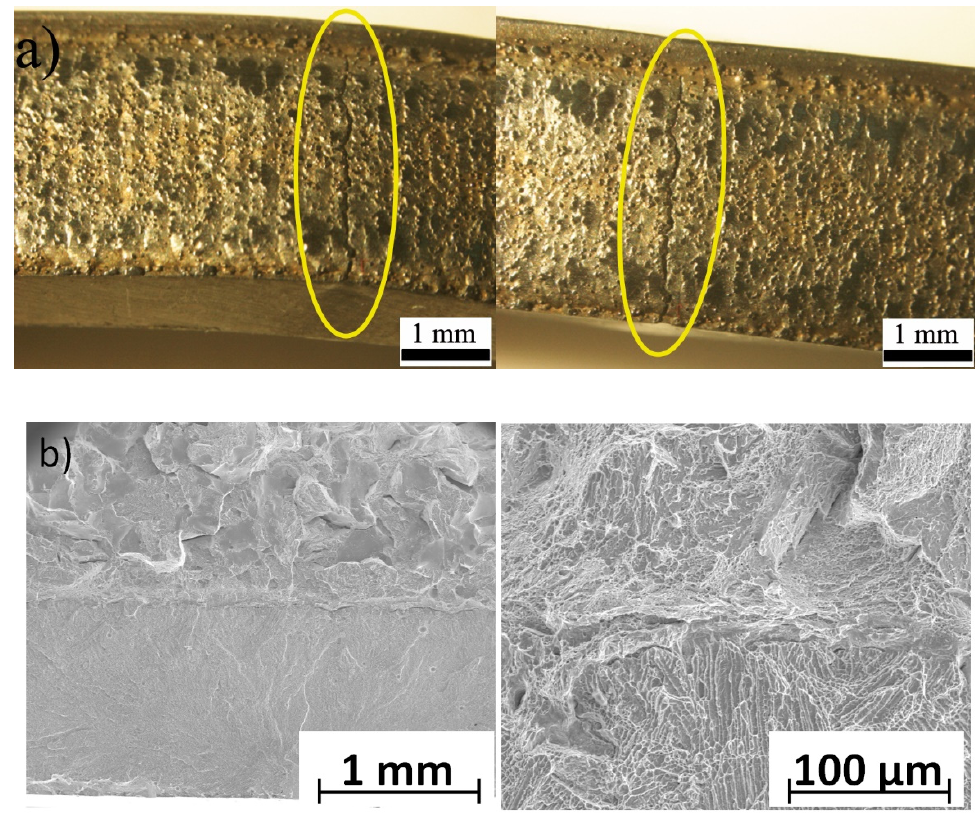
Figure 10. Surface of the Co-6 coating #4 deposited by LENS after the bending test ( a ) and fracture surface of the Co-6 coating, SEM ( b surface of the Co-6 coating, SEM ( b ) .